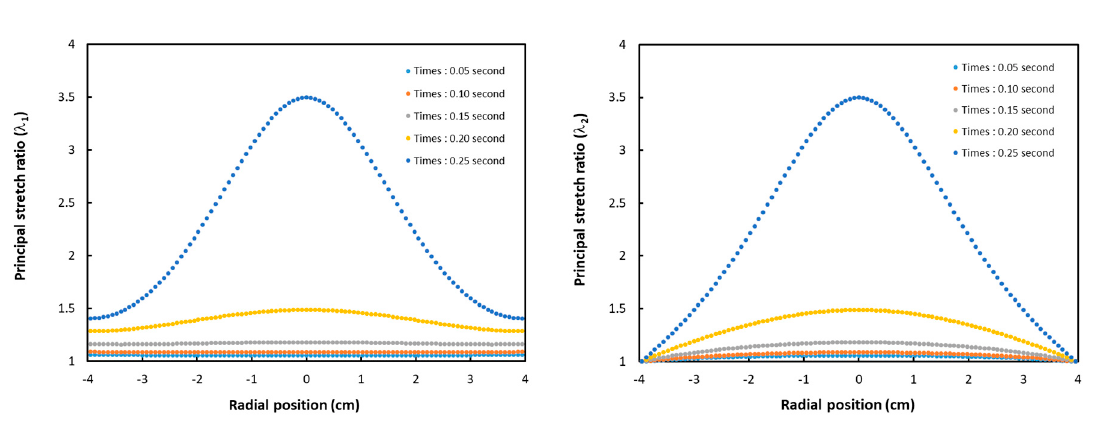
Table 3. Stiffness modulus and relaxation time for the PMSQ–HDPE nanocomposite at T = 130 °C.